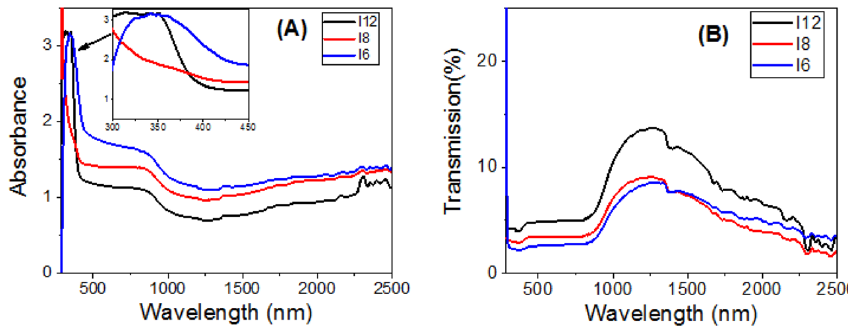
Figure 6. Effective optical ( A ) absorbance and ( B ) transmittance spectra of I-6, I-8, and I-12 in liquid crystal phase designed at 140 °C.